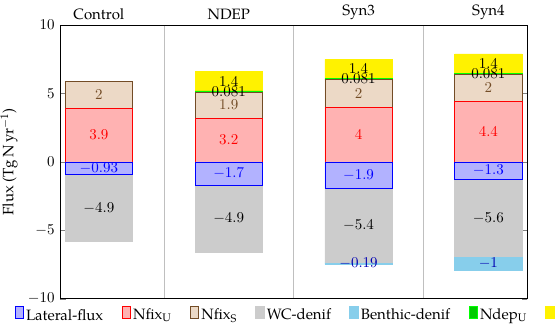
Figure 2. Nitrogen fluxes after including atmospheric nitrogen de- position in the control, Syn3 and Syn4 configurations defined in Table 1. Lateral-flux is the nitrogen efflux or influx through the southern boundary; Nfix U and Nfix S represent the nitrogen fixa- tion rate by NF, respectively, in the U and S boxes; WC-denif is water-column denitrification; Ndep U and Ndep S are the nitrogen input into surface U and S boxes via nitrogen